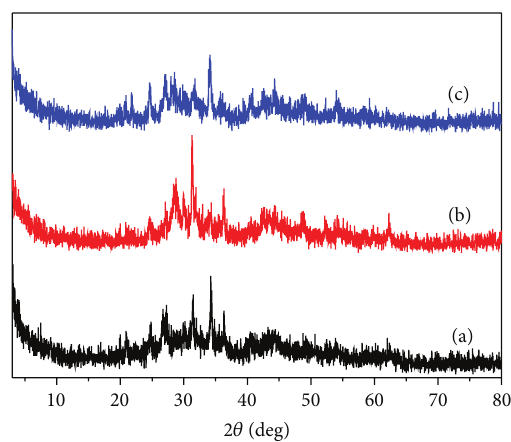
Figure 2: Powder X-ray diffraction patterns of the Fe-Ni-Pb-B alloy nanoparticles: (a) resultant 1 , (b) resultant 2 , and (c) resultant 3